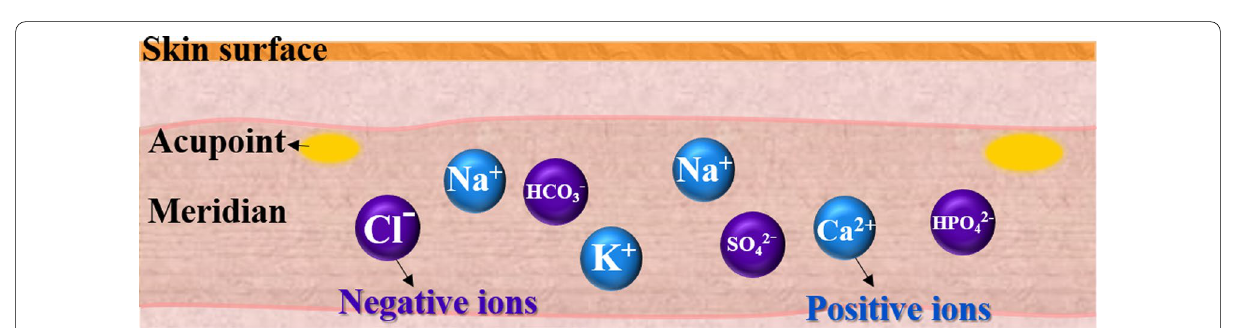
Fig. 4 Uniform distribution and diffusion of ions in the meridian without the electron field